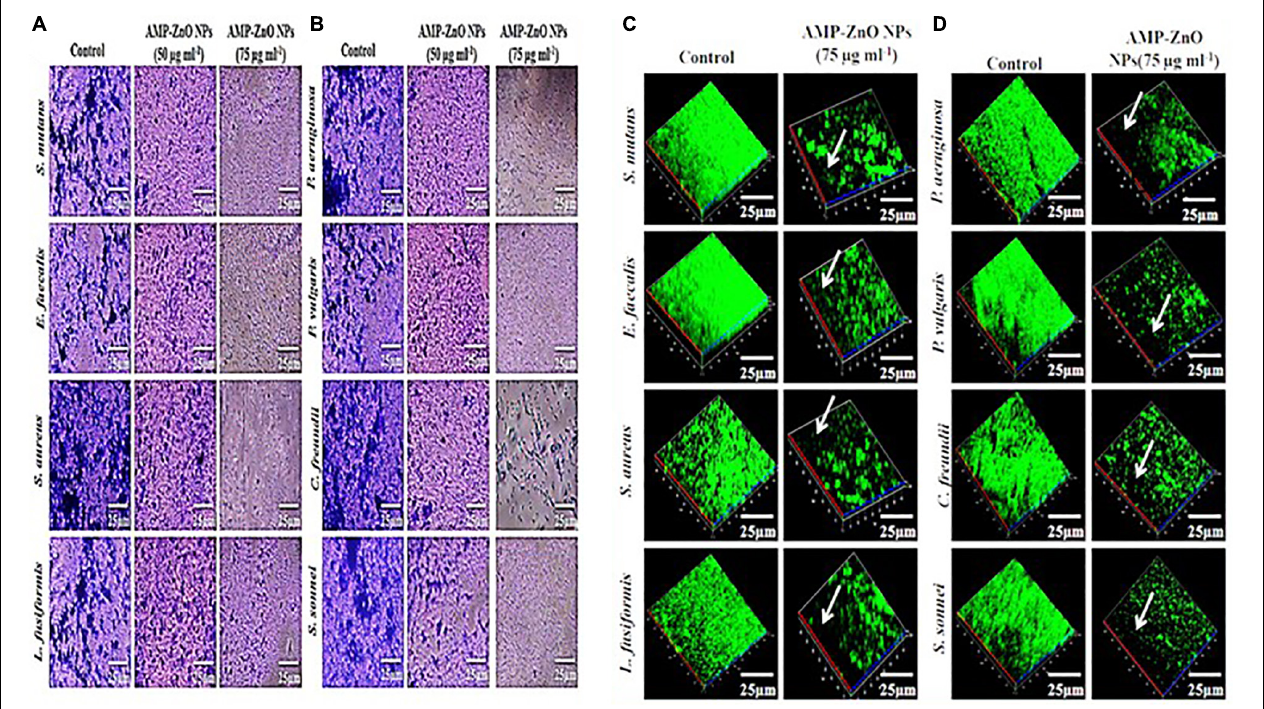
FIGURE 9 | (A,B) Light micrographs show the antibiofilm activity of HAMP-ZnONPs (50 µ g/ml and 75 µ g/ml) against (A) Gram positive ( Staphylococcus aureus, Streptococcus mutans , Enterococcus faecalis and Lysinibacillus fusiformis ) and (B) Gram negative bacteria ( Shigella sonnei , Pseudomonas aeruginosa , Proteus vulgaris and Citrobacter freundii) . The cells were stained with crystal violet. (C,D) Confocal laser scanning micrographs show the antibiofilm activity of HAMP-ZnO NPs (75 µ g/ml) against (C) Gram positive ( Staphylococcus aureus, Streptococcus mutans , Enterococcus faecalis and Lysinibacillus fusiformis ) and (D) Gram negative bacteria ( Shigella sonnei , Pseudomonas aeruginosa , Proteus vulgaris , and Citrobacter freundii) . The cells were stained with acridine